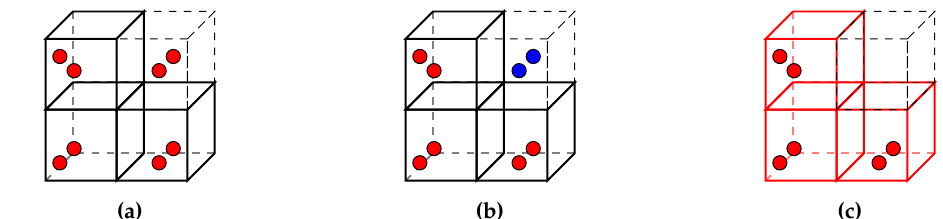
Figure 5. Simplified illustration of the point cloud subtractor using the octree to subtract points that do not belong to the as-planned representation of an inspection object. ( a ) Input point cloud (red points) aligned with voxels of as-planned representation (solid boxes). ( b ) Elimination process: discard points that do not match an octree leaf (blue points). ( c ) Result: matched octree leafs are marked occupied